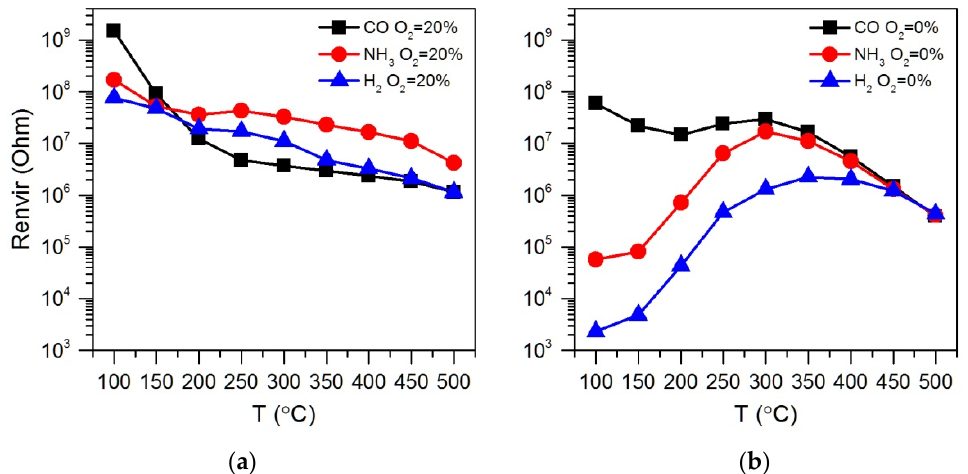
Figure 6. Temperature dependences of ZnO/Pd resistance in dry atmosphere (RH = 0%) with different oxygen backgrounds 20% O 2 ( a ) and 0.0005% O 2 ( b ) after interaction with 100 ppm of reducing gases CO, NH 3 or H 2 .